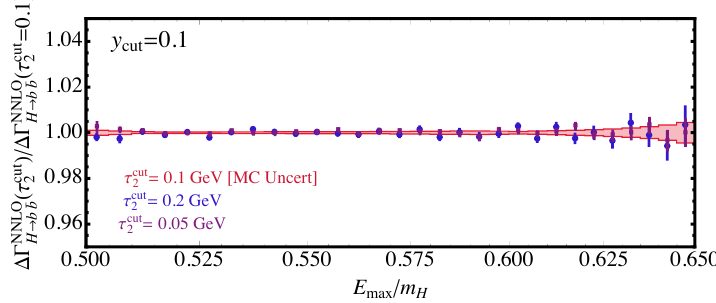
Figure 3 . The dependence of the di(cid:11)erential distribution for the maximum jet energy in the NNLO two-jet rate on the N -jettiness slicing parameter (cid:28) cut